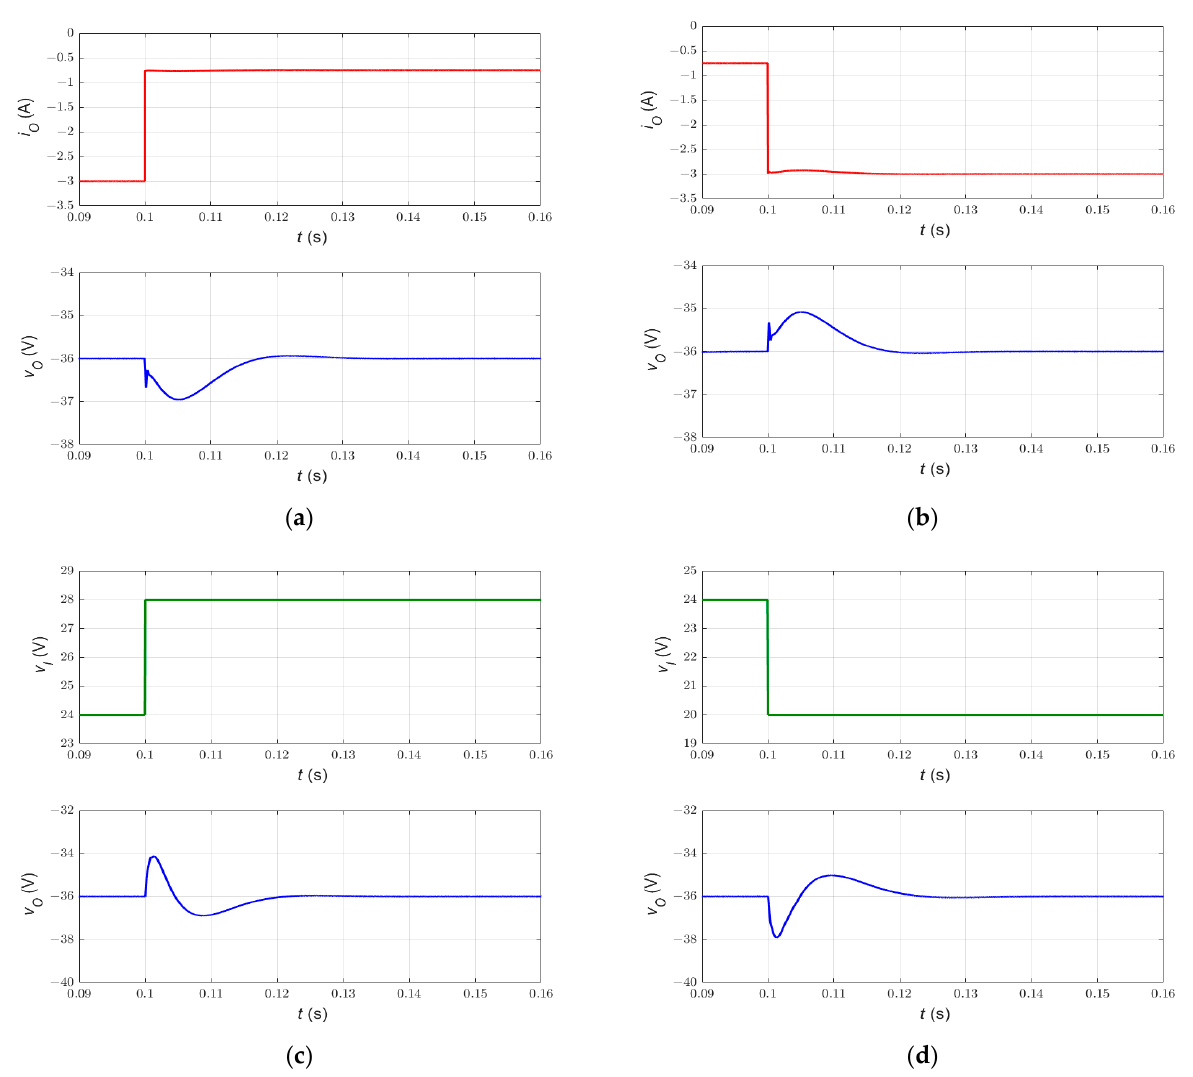
Figure 7. Transient response of simplified double-integral sliding-mode current control of the PWM DC-DC Cuk converter. The response during step ( a ) decrease and ( b ) increase in load current i O . The response during step ( c ) increase and ( d ) decrease in input voltage v I . Table 3. The transient response characteristics of the proposed nonlinear controlled PWM DC-DC Cuk converter in CCM.